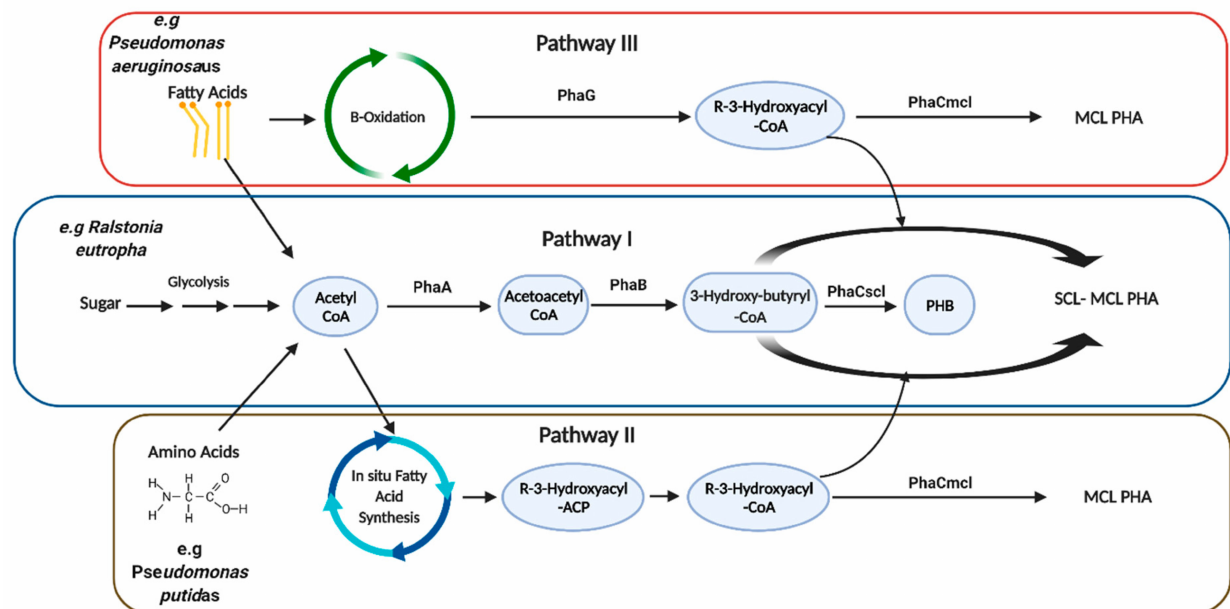
Figure 4. The Major PHA Biosynthesis Pathways. Acetoacetyl-CoA pathway (pathway I), in situ fatty acid synthesis (pathway II) and/or beta-oxidation cycles (pathway III). PHA diversity is generated through engineering the three basic synthesis pathways as well as PHA synthase